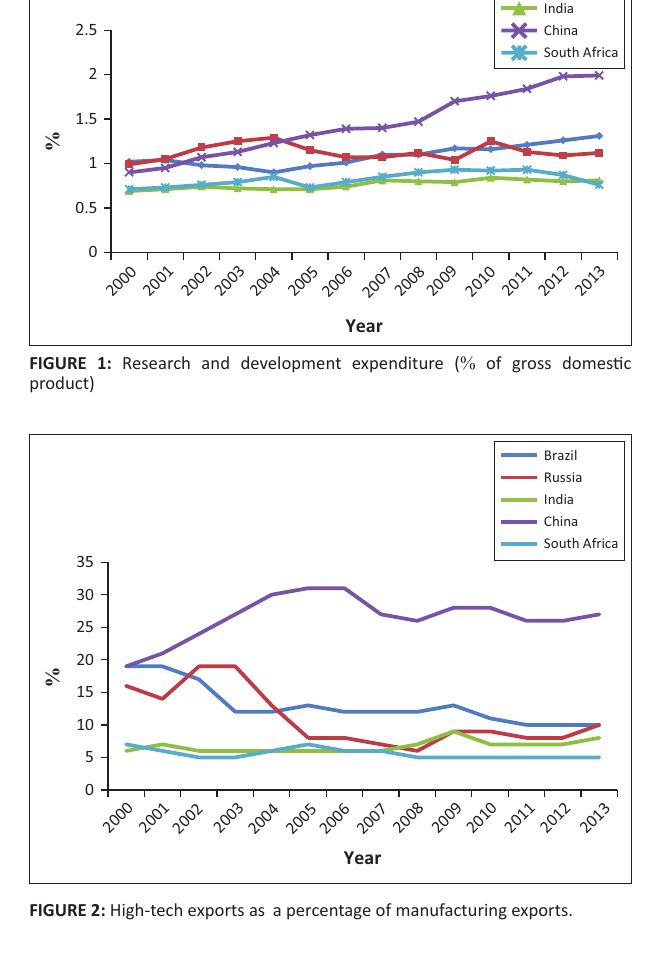
TABLE 1: Research and development expenditure ( % of gross domestic product). Country